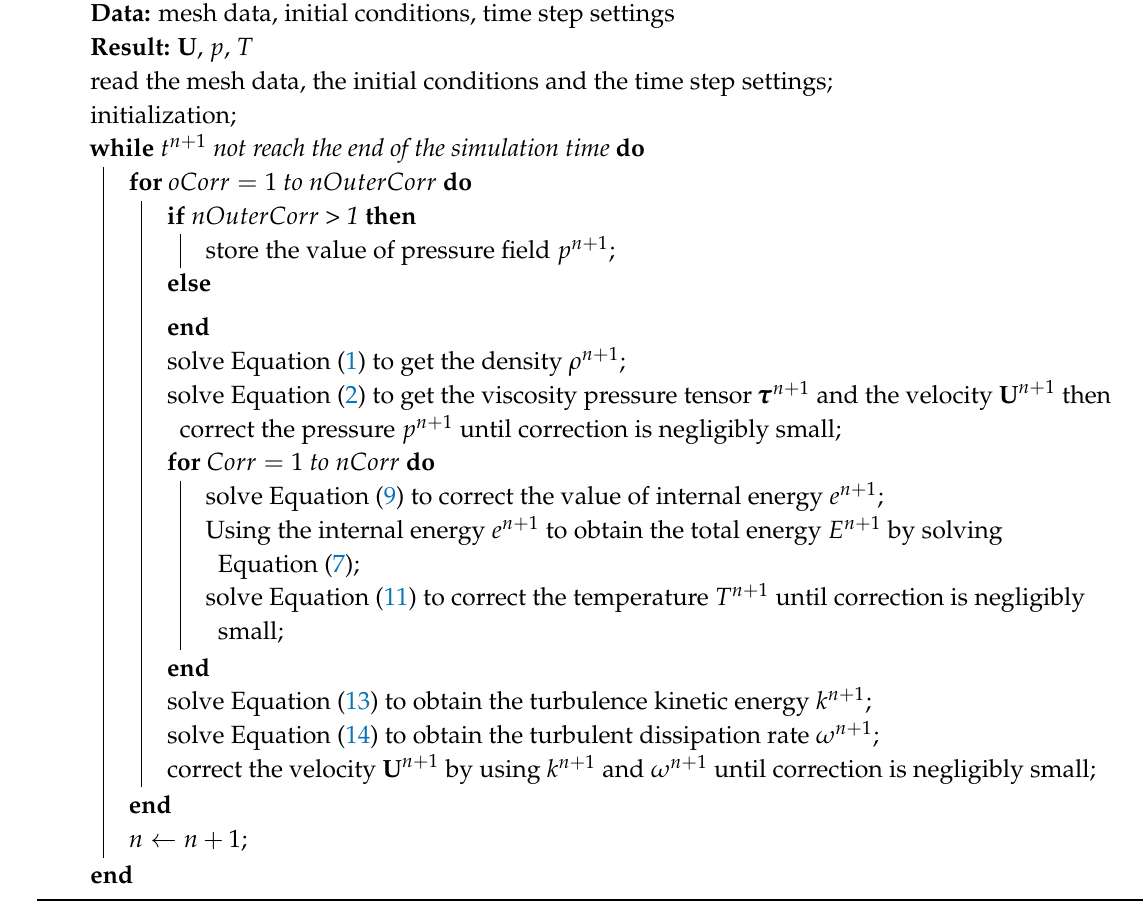
Algorithm 1: The iterative algorithm to solve the compressible idea gas fluid model for simulating the steam dumping process.